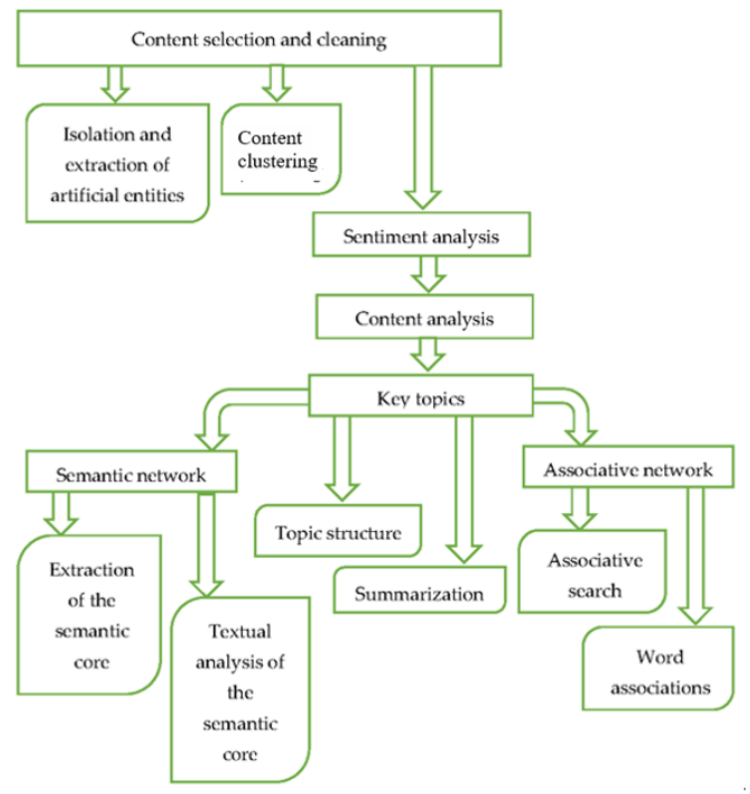
Figure 4. Design of digital content analysis.